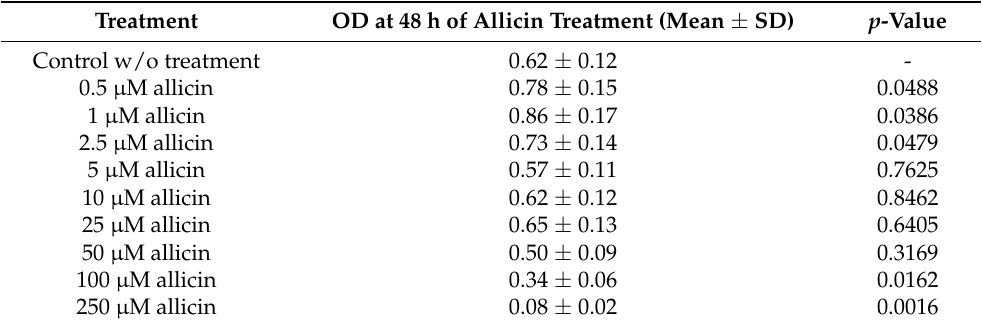
Table 3. MTT assay for cell viability of CD3+ T lymphocytes treated with different concentrations of allicin.